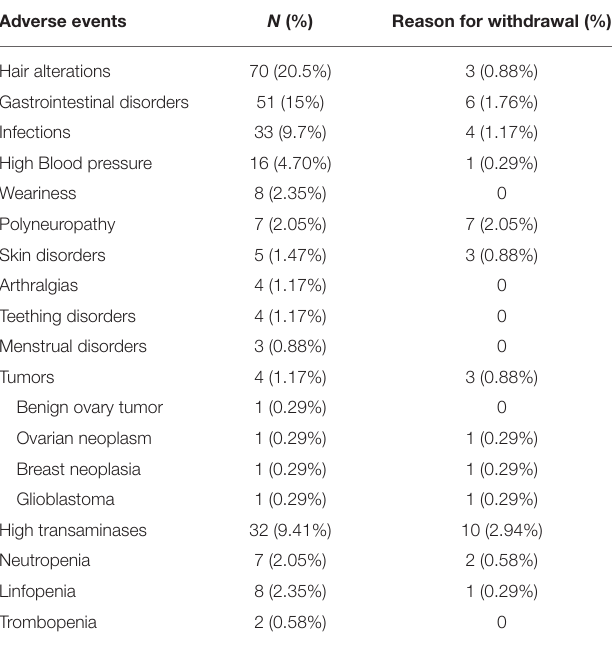
TABLE 3 | Adverse events, prevalence, and reason for